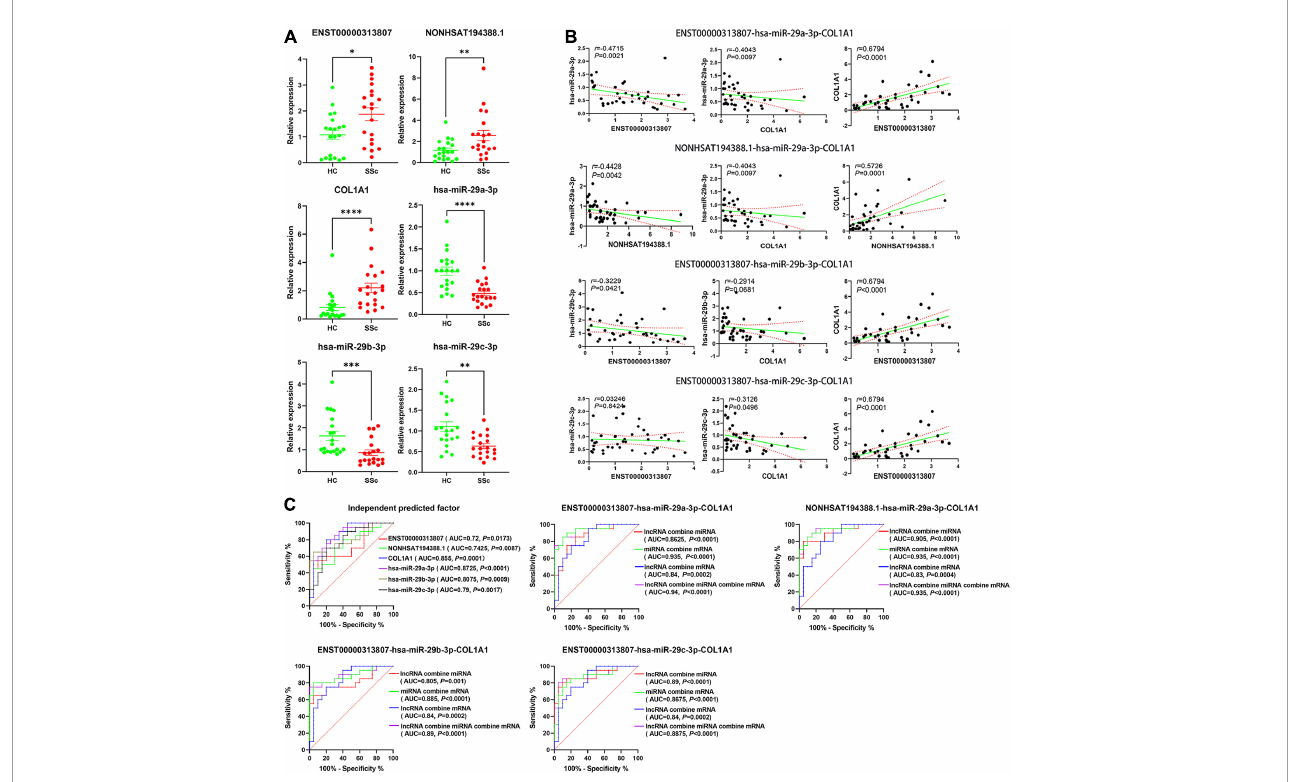
FIGURE11 (A) The relative expression of ENST00000313807, NON-HSAT194388.1, COL1A1 , hsa-miR-29a-3p, hsa-miR-29b-3p, and hsa-miR-29c-3p in plasma cirexos was verified by Real-time Quantitative PCR (RT-qPCR) ( n = 20). The green part shows the relative expression of RNA in healthy control; (HCs). The red part shows the relative expression of RNA in patients with SSc. ∗ P < 0.05, ∗∗ P < 0.01, ∗∗∗ P < 0.001, and ∗∗∗∗ P < 0.0001. (B) Correlation analysis of the ENST00000313807-hsa-miR-29a-3p- COL1A1 networks, NON-HSAT194388.1-hsa-miR-29a-3p- COL1A1 networks, ENST00000313807-hsa-miR- 29b-3p- COL1A1 networks, and ENST00000313807-hsa-miR-29c-3p- COL1A1 networks found in plasma cirexos ( n = 20). The solid green line is a regression straight line, which is used to describe the relationship curve between the dependent variable y and the independent variable x with a linear relationship. The area formed by the red dotted line represents the 95% confidence interval. (C) Receiver operating characteristic (ROC) curve analysis of the independent diagnosis of ceRNA networks, ENST00000313807-hsa-miR-29a-3p- COL1A1 combined diagnosis, NON-HSAT194388.1-hsa-miR-29a- 3p- COL1A1 combined diagnosis, ENST00000313807-hsa-miR-29b-3p- COL1A1 combined diagnosis, and ENST00000313807-hsa-miR-29c-3p- COL1A1 combined diagnosis in plasma cirexos ( n = 20). AUC, area under